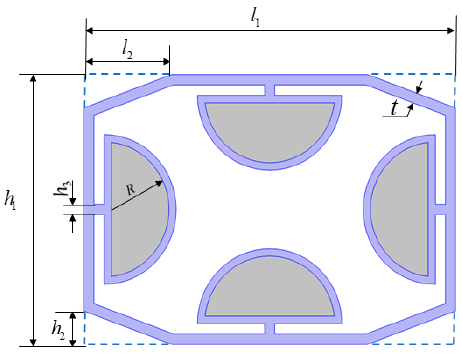
Figure 7. Frame material structure diagram with counterweight blocks.